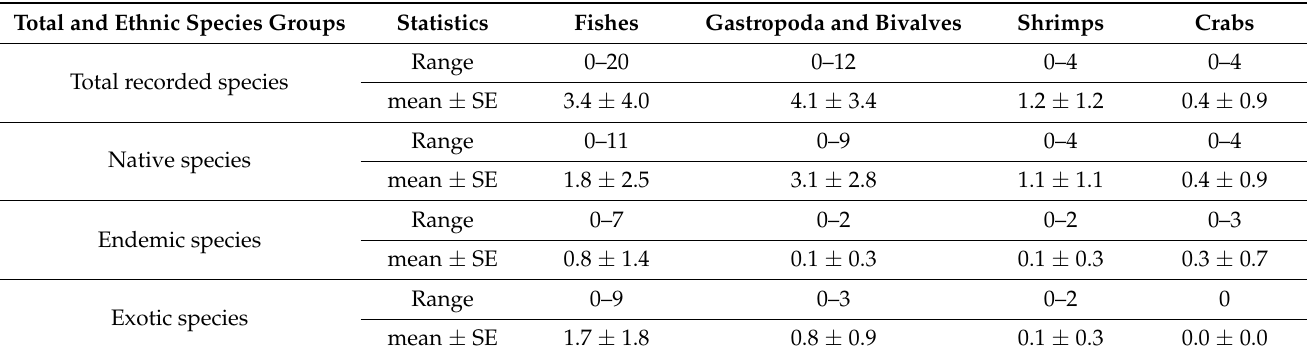
Table 4. Range and mean values of total recorded species, native species, endemic species, and exotic species of collected fishes, gastropoda and bivalves, shrimps, and crabs in the 58 sampled springs in